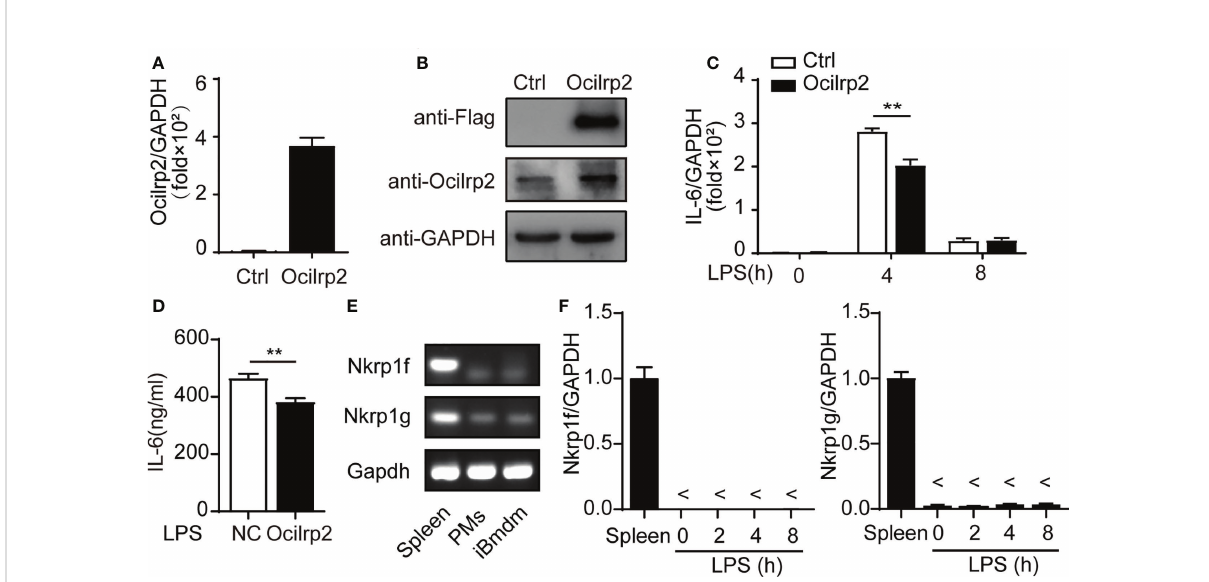
FIGURE 3 Ocilrp2 downregulated LPS-induced IL-6 expression independent Nkrp1f/Nkrp1g. (A, B) Western Blot analysis overexpression Ocilrp2-Flag in iBMDM cells. (C) IL-6 mRNA levels were detected with qRT-PCR in control, and Ocilrp2-overexpression cells were stimulated with LPS at the indicated time points. (D) Supernatants were collected 8 h after LPS stimulation, and IL-6 production was measured with ELISA. (E) PCR products of the Nkrp1f and Nkrp1g were detected in the lysate of Spleen cells, peritoneal macrophages, and iBMDM cells. (F) Nkrp1f and Nkrp1g mRNA levels were detected with qRT-PCR in Spleen, and peritoneal macrophages were stimulated with LPS at the indicated time points. GAPDH is used as an internal loading control in the experiments. Data were calculated from at least 3 independent experiments (means ± s.e.m), ** P < 0.01 (The two-tailed Student ’ s